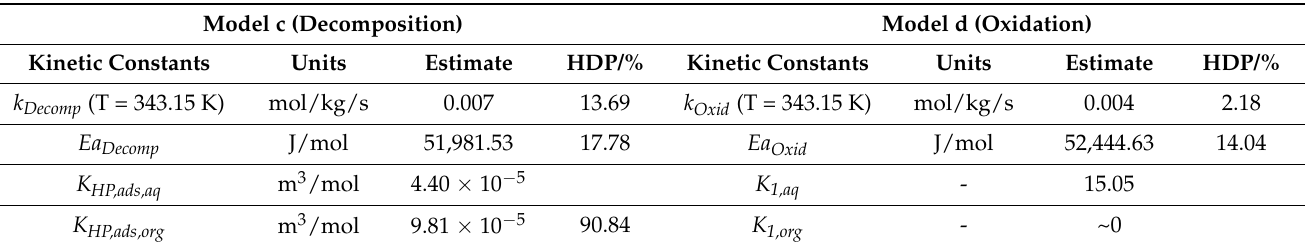
Table 6. Estimated kinetic constants and credible intervals for Models c and d for the heterogeneous liquid phase system. Model c (Decomposition)